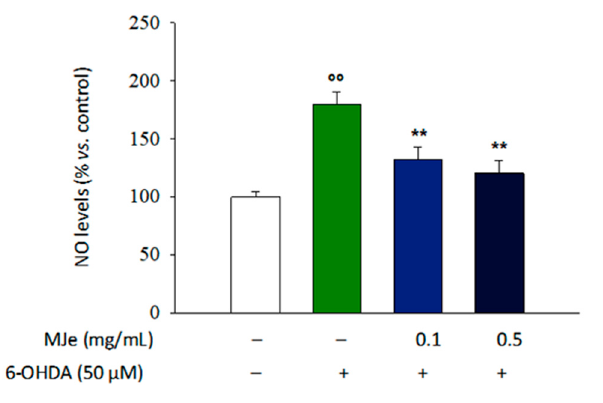
Figure 8. MJe prevented the release of NO induced by 6-OHDA. The levels of NO were measured by a colorimetric assay. Differences in NO production are reported as percentage of NO value detected in treated cells compared to those found in untreated ones. Results are expressed as means ± SEM from three independent experiments in triplicate (N = 9). ◦◦ p < 0.01 vs. ctrl; ** p < 0.01 vs. 6-OHDA 50 μ M.